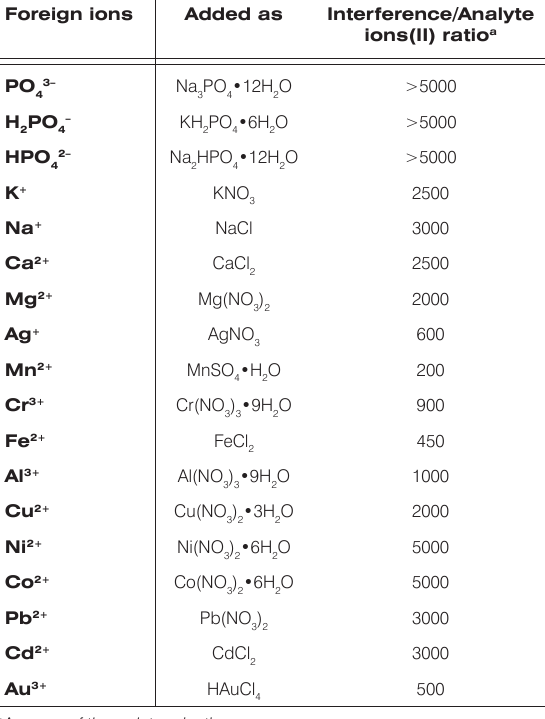
Table 2. Tolerance limit of the foreign ions. Foreign